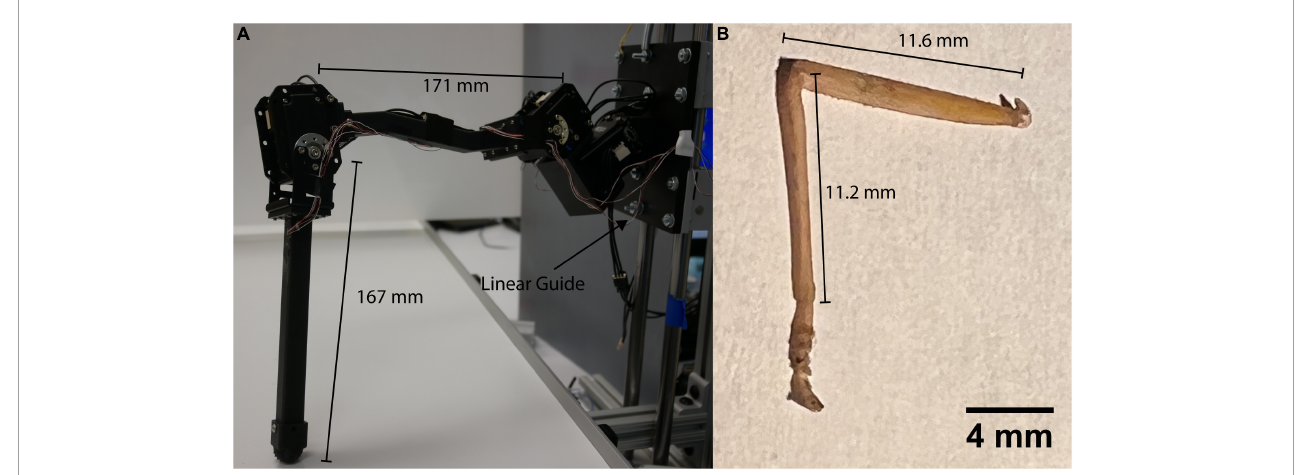
FIGURE1 (A) C. morosus robotic model of the middle leg connected to a linear guide. The linear guide is constrained to movement in the vertical direction or z axis. The free movement in the vertical directions forces the leg to support its own weight as it steps on the treadmill. (B) Middle leg of a C. morosus for biological size and degrees of freedom comparison.